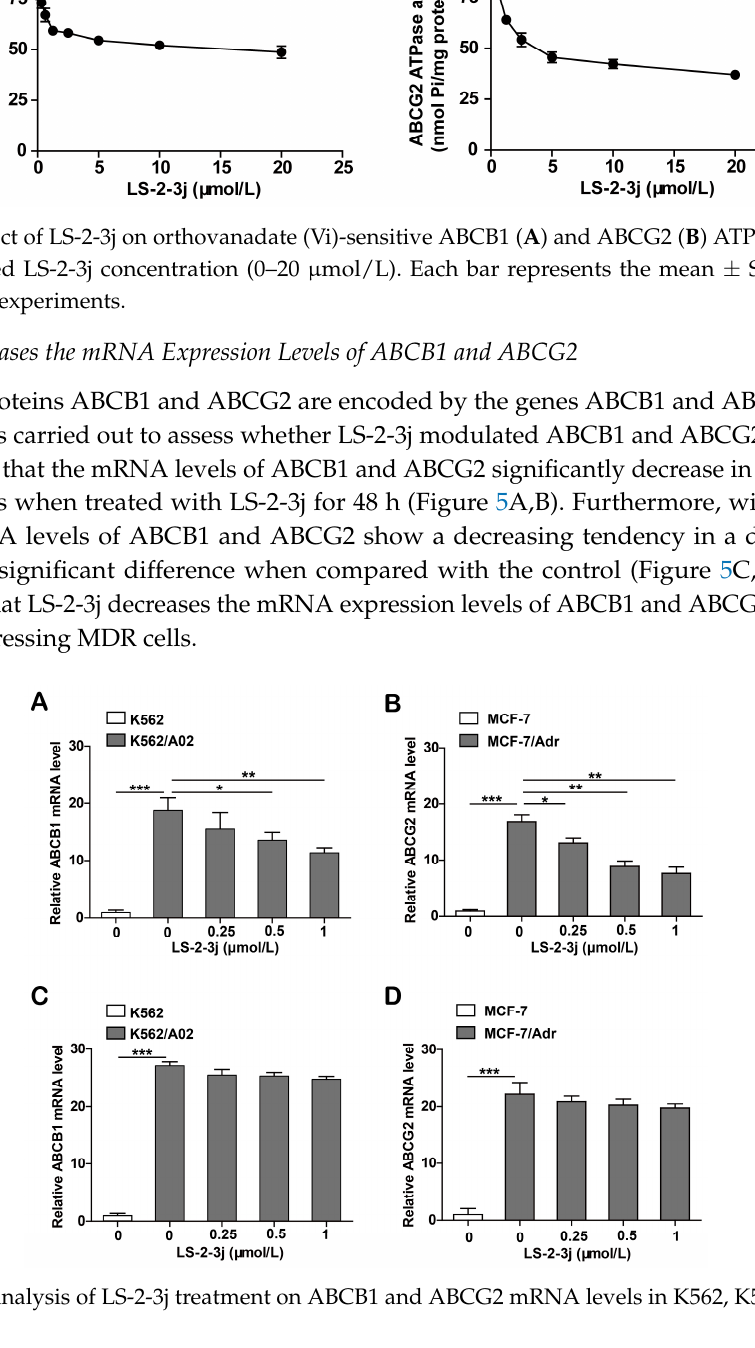
Figure 3. LS-2-3j inhibited the efflux of DOX and MITX. ( A , B ) The effect of LS-2-3j on the efflux of